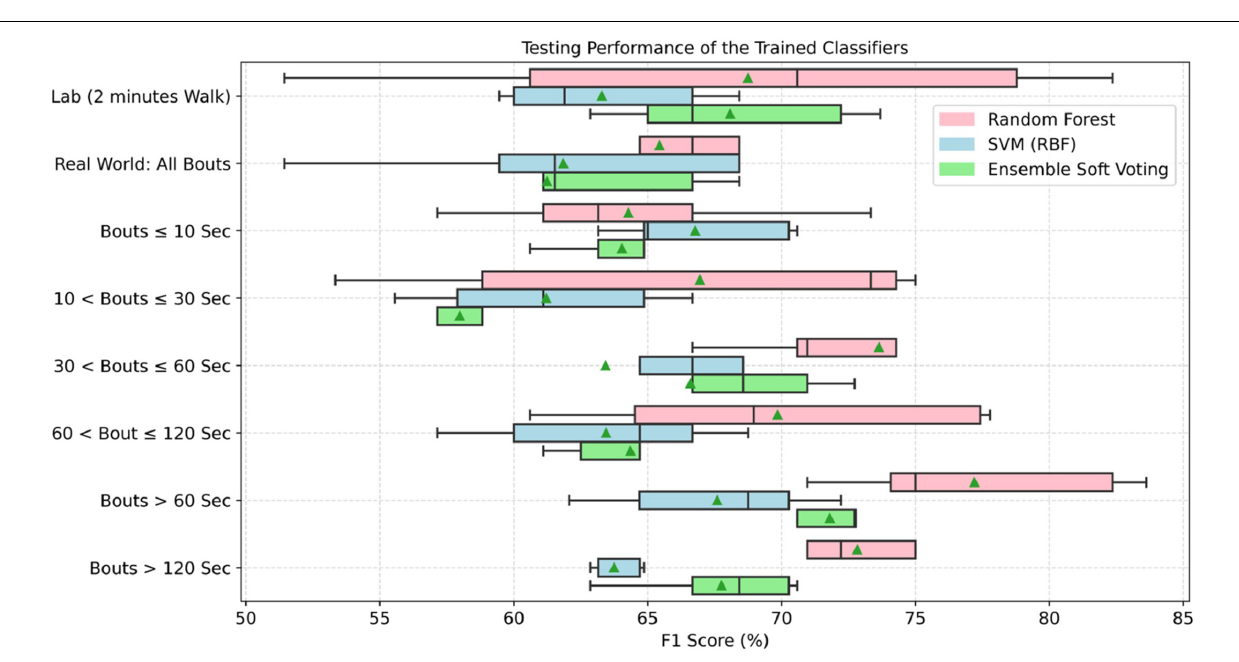
straight lines in the real-world (Galperin et al., 2019; Hillel et al., 2019), which cannot be evaluated using a